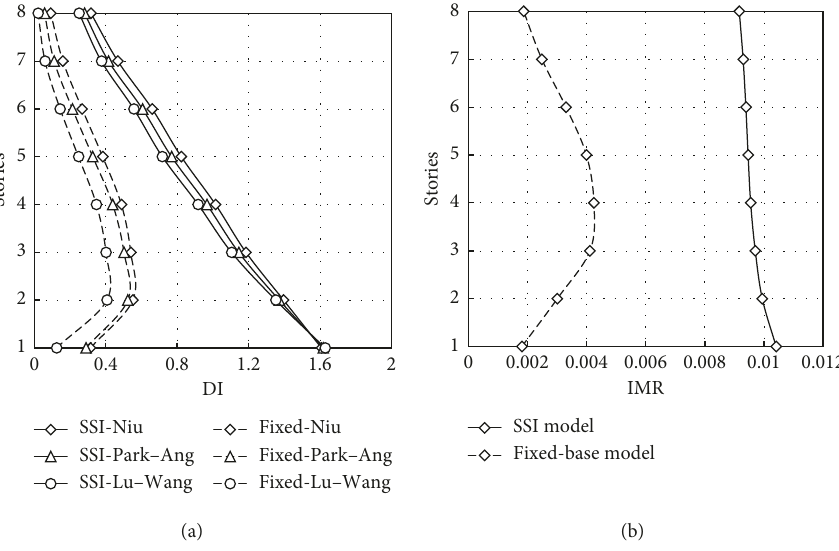
Figure 7: Distribution of damage at PGA of 0.4g with DPDMs (a) and the MIDR (b).